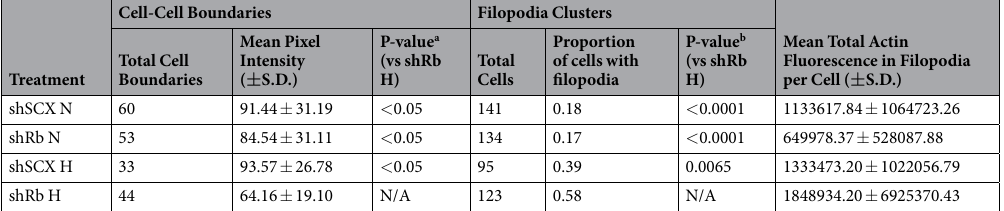
amount of actin in the filopodia-like clusters was too difficult to parse out as the areas of defined clusters varied widely within the cell populations making the standard deviations of quantified measurements too large for sta- tistical significance (Fig. 6C, Table 1 and Supplementary Dataset Files 1 and 2). Nevertheless, our morphological analysis supports the results we obtained from our mechanical characterization studies and suggests that Rb-loss significantly changes the organization of actin in hypoxic LNCaP cells. Raw values for all our measurements can